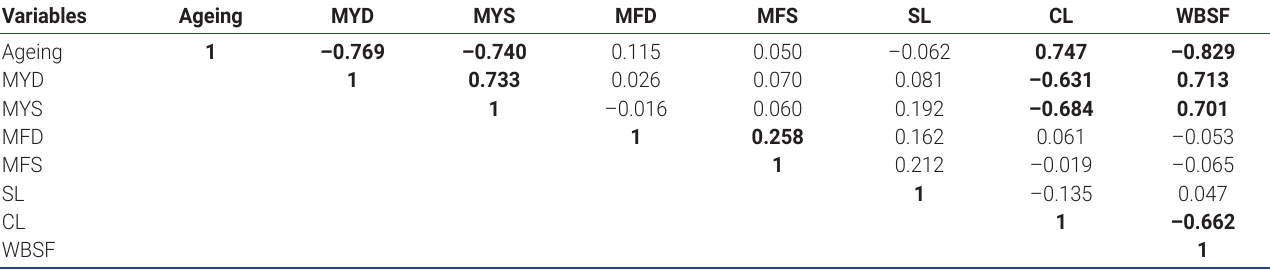
Table 2. Correlations among nanostructure, tenderness and cooking loss Variables